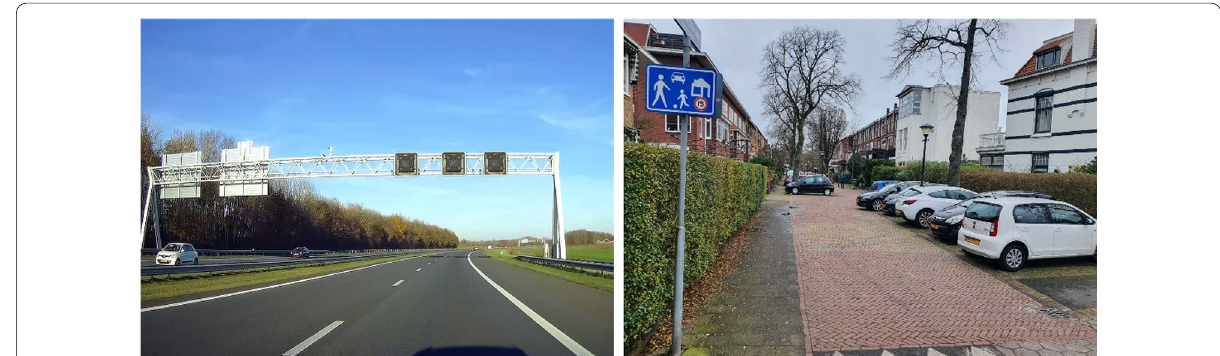
Fig. 4 Two types of roads which can be considered to be self-explaining. On the left a typical Dutch motorway with defining features for fast driving such as wide lanes, smooth asphalt, an emergency lane, guard rails, overhead lane control signs, no sharp curves and a lot of preview. On the right, a typical Dutch woonerf (also known as “shared space”) designed for slow driving (maximum speed 15 km/h) with defining features such a physical barriers, shared and paced space and landscaping and street